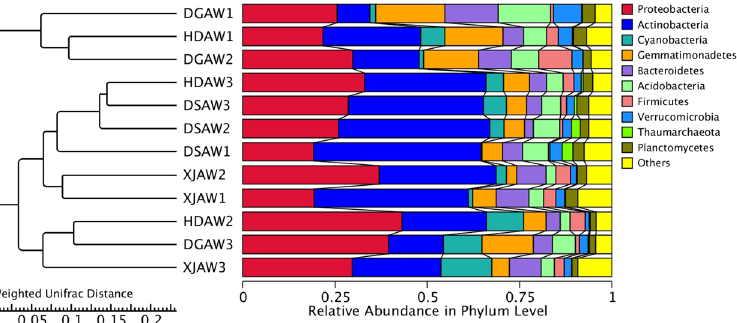
Figure 5. UPGMA tree based on Weighted UniFrac Distance at the phylum level. Explanation: On the left is the UPGMA cluster tree structure, on the right is the species relative abundance distribution at the phylum level for each sample. The phylogenetic relationship of the bacterial isolates was determined by PCR sequencing portions of the 16S rRNA gene. The phylogenetic tree showed that the bacterial communities were divided into three major groups, with each group containing samples from different soil depths and different Ferula species. The samples within each group were always from adjoining depths (i.e., either the 3 and 20 cm depths or the 20 and 40 cm depths). This indicated that soil depth had some effect on bacterial community structure. The bacterial communities in the three replicates were highly similar, which is probably because the samples were collected from close proximity. Abbreviations: HDAW, F. syreitschikowii ; XJAW, F. gracilis ; DSAW, F. ferulaeoides; and DGAW, F. lehmannii . The numbers indicate the root depth (1, 2, and 3 represent the 3, 20, and 40 cm depths,